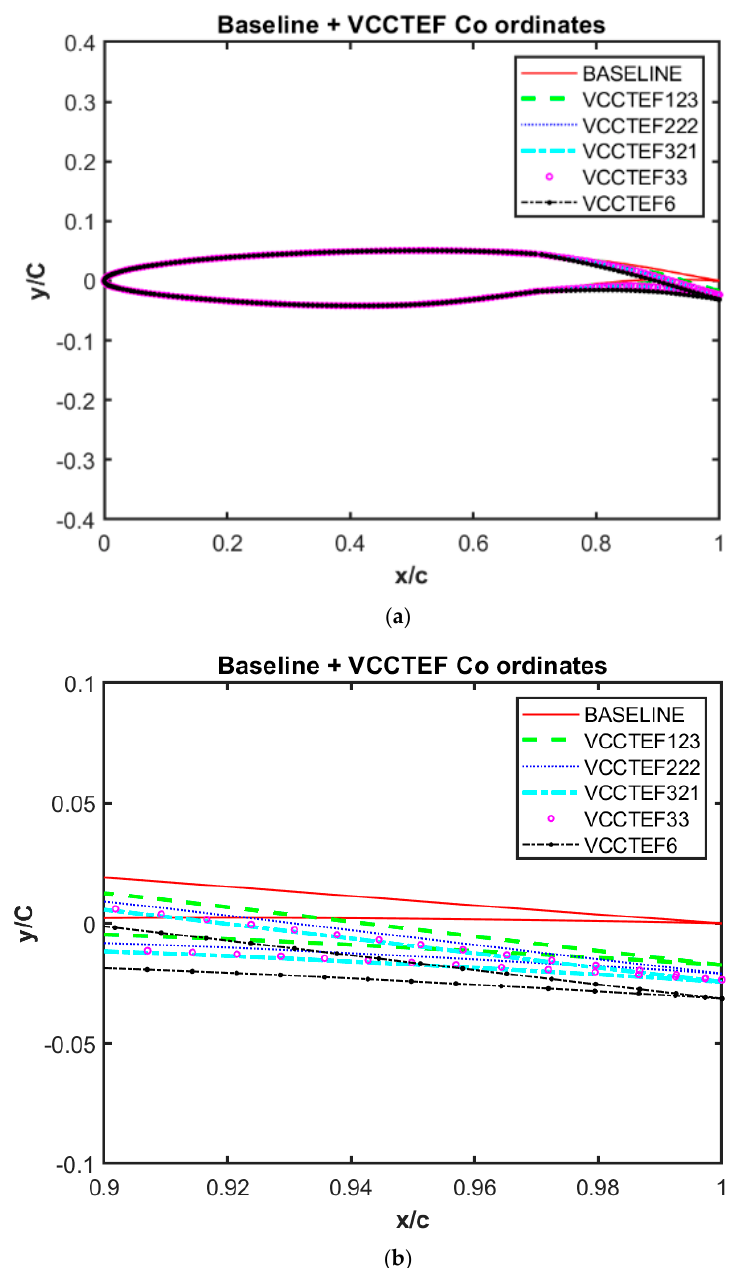
Figure 6. ( a ) Comparison of baseline coordinates with VCCTEF airfoils and their ( b ) enlarged view at the trailing edge.